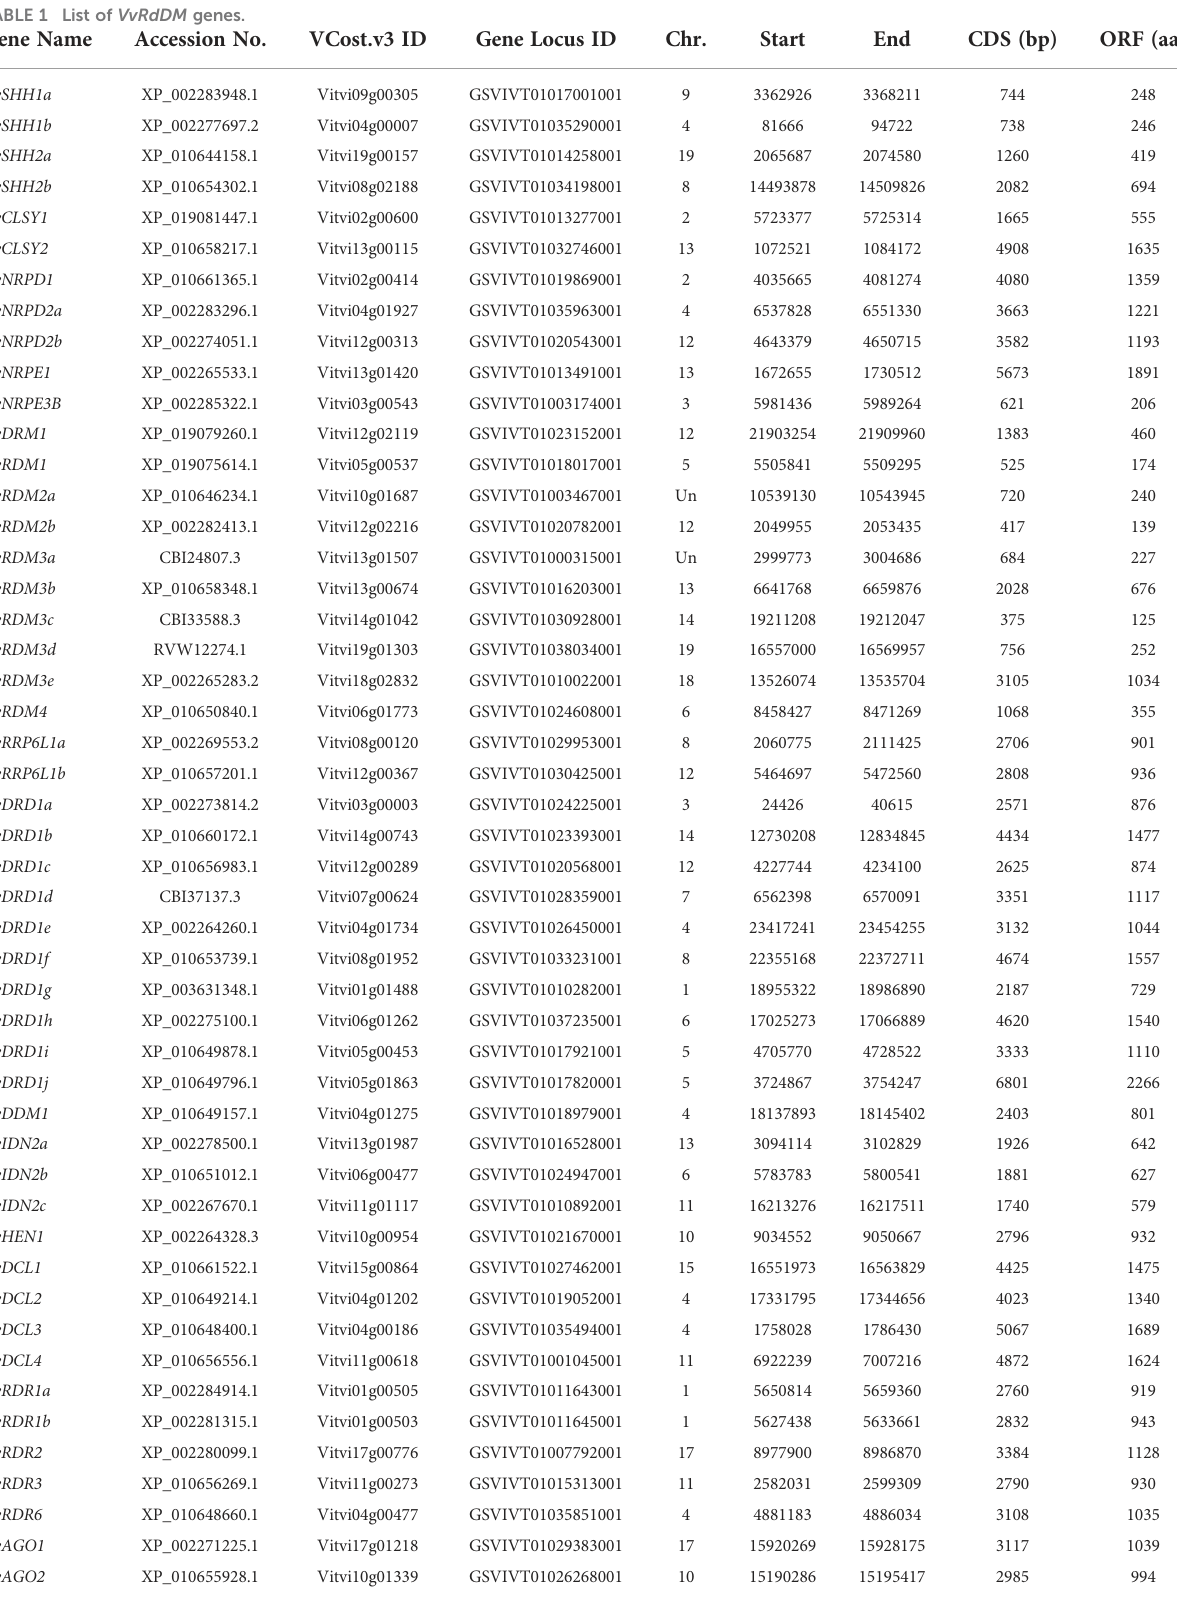
TABLE 1 List of VvRdDM genes. Gene Name Accession